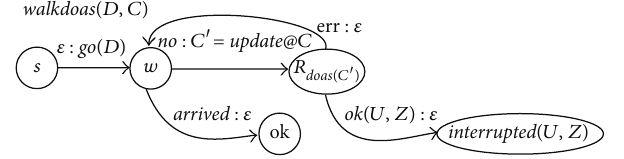
Figure 9: Dialogue model for walk DOA behaviour.